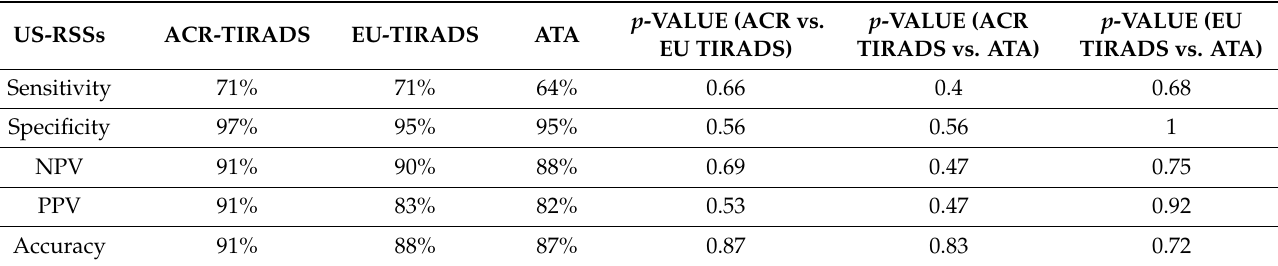
Table 2. Diagnostic performances of the